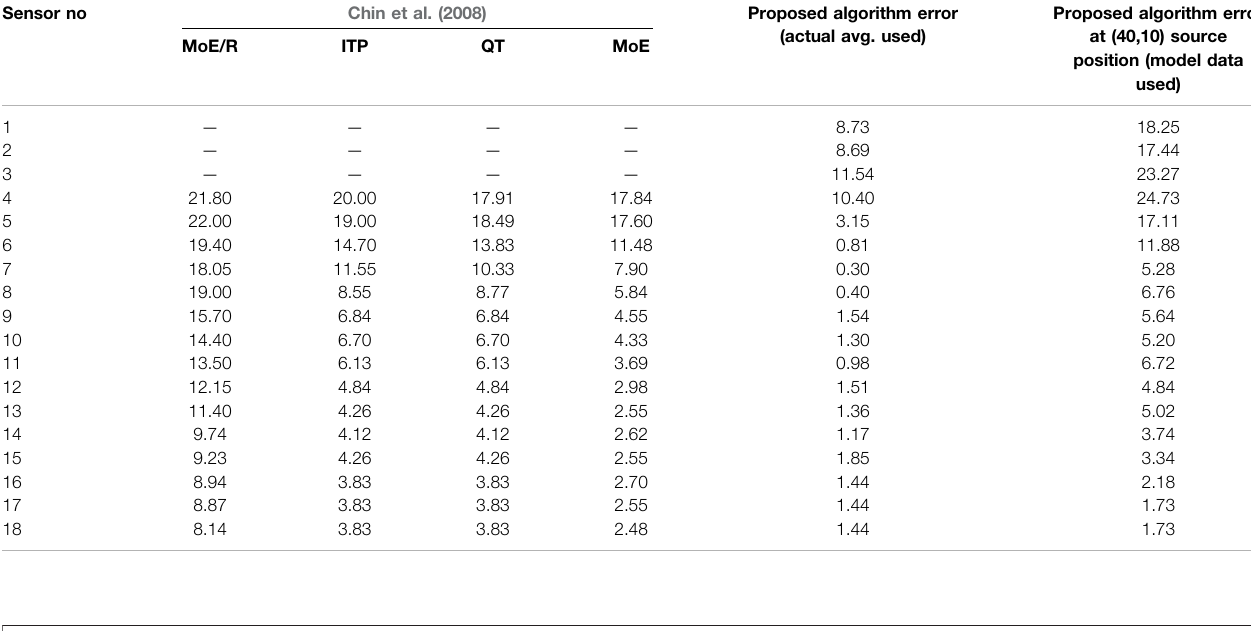
(actual avg. used)